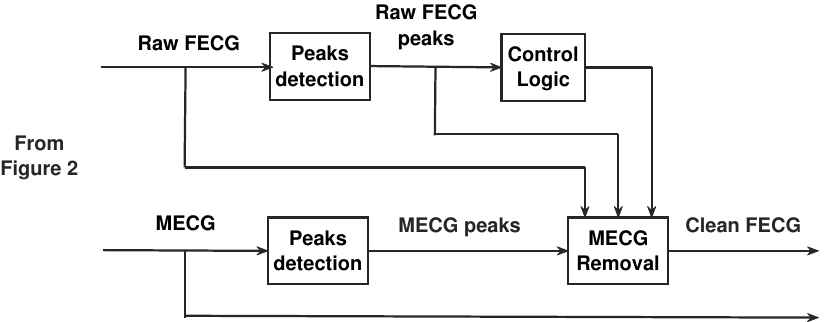
Figure 3. Typical extracted MECG and raw FECG signals from the system shown in Figure 2. The red dashed lines and the black dotted circles represent the locations ( p and the components of the unwanted MECG signals in the raw FECG signal, respectively. The doubled black arrows indicate the locations of the adaptive comb filter (ACF), of length 2 U + 1, required to remove the MECG components.